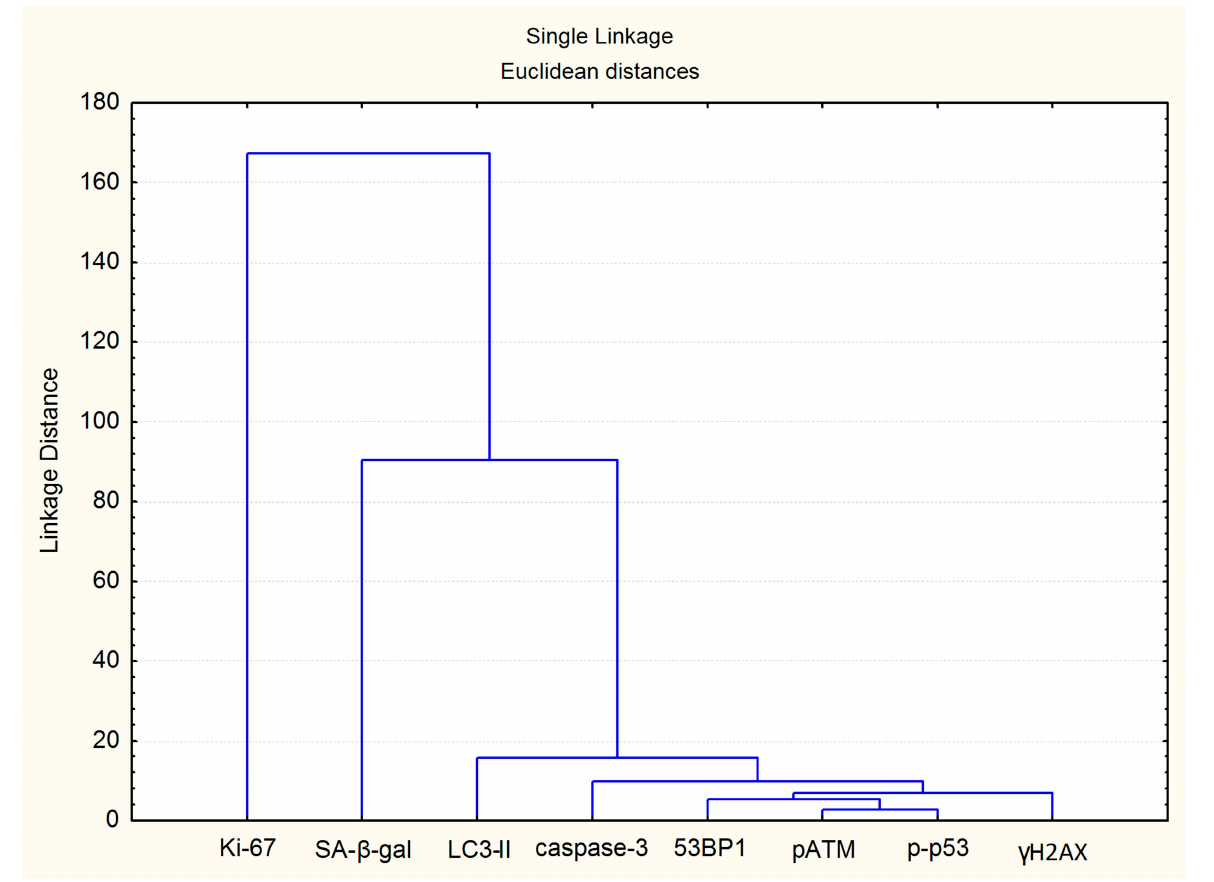
Figure 11. Clustering tree for the investigated endpoints.